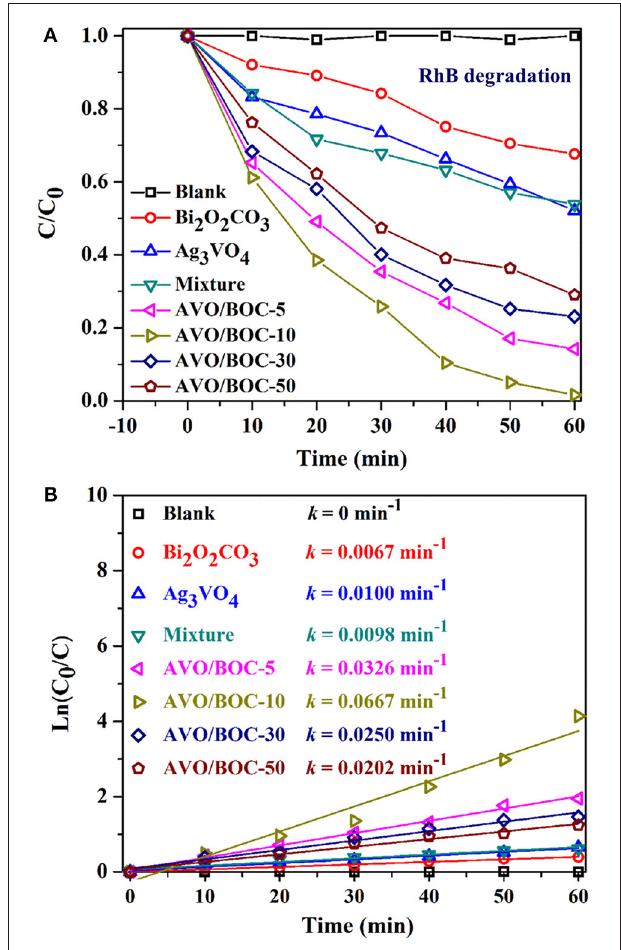
FIGURE 5 | (A) Photocatalytic degradation efficiency of RhB over different catalysts under visible light. (B) Rate constants of RhB degradation during reaction over different